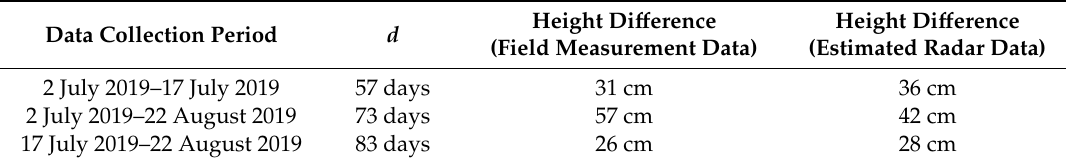
Table 3. Comparison between field measurement data and estimated radar data in the corn crop for height difference information.